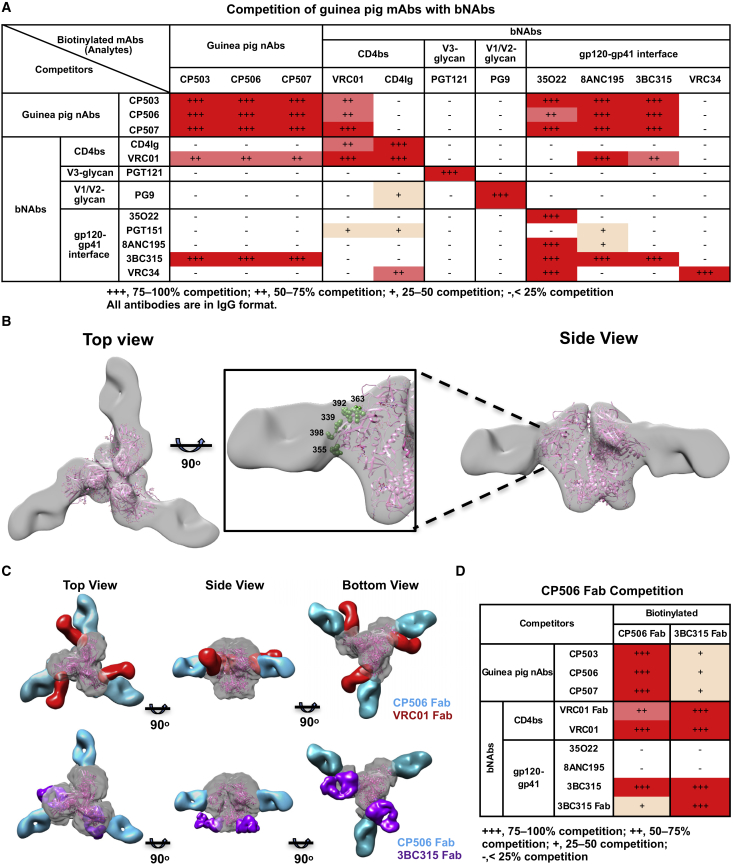
Guinea Pig NAbs Target the C3 and V4 Region on BG505 SOSIP.664(A) Cross-competition of guinea pig NAbs with epitope well-defined bNAbs for binding to BG505 SOSIP.664 trimer. Data were generated in duplication, with selected reactions repeated at least twice.(B) 3D EM reconstruction of CP506 Fab/BG505 SOSIP.664 complex. The crystal structure of BG505 SOSIP.664 trimer (PDB: 4TVP), displayed in pink ribbons, is docked into the trimer EM density. Five N-linked glycans at the contact interface are highlighted in green, labeled with respective residue numbers.(C) Comparison of the mode of CP506 binding to BG505 SOSIP.664 Env trimer with bNAbs VRC01 (upper) (EMDB: EMD-6193) and 3BC315 (lower) (EMDB: EMD-3067), which recognizes the CD4bs and gp120/gp41 interface of Env, respectively.(D) Competition ELISA assay using biotin-labeled CP506 Fab and 3BC315 Fab as analytes confirms competition between CP506 lineage NAbs and bNAbs, including VRC01 and 3BC315. Data were generated in duplication, with reactions of 3BC315 Fab repeated twice.